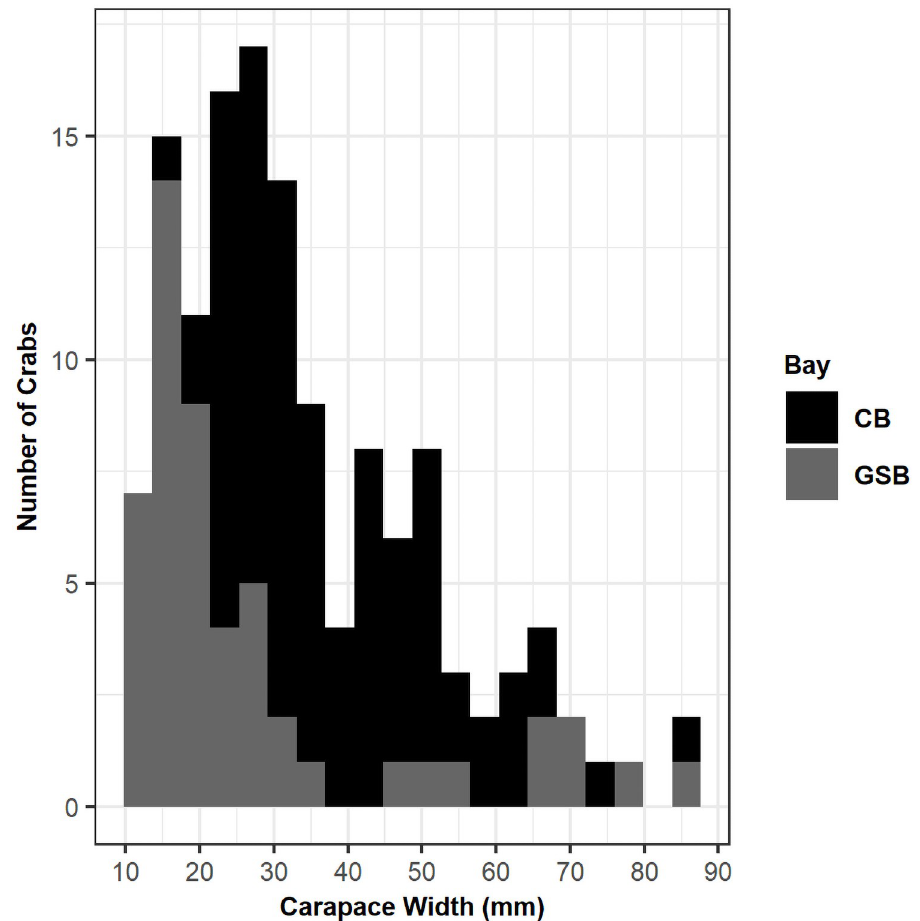
Fig 4. Histogram of crab sizes used in experimental year 2 (2017). Black bars show the number of crabs used in the 2017 experiments from CB in 10 mm size bins, and gray bars show the number of crabs from GSB.